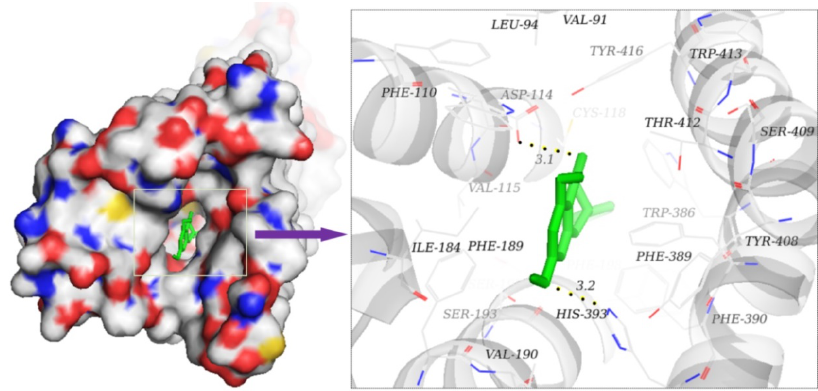
Figure 8. Binding mode prediction of naringenin to D 2 R via AutoDock. Naringenin is shown in green stick form and black dashed lines are hydrogen bonds. The figure was prepared with PyMol.